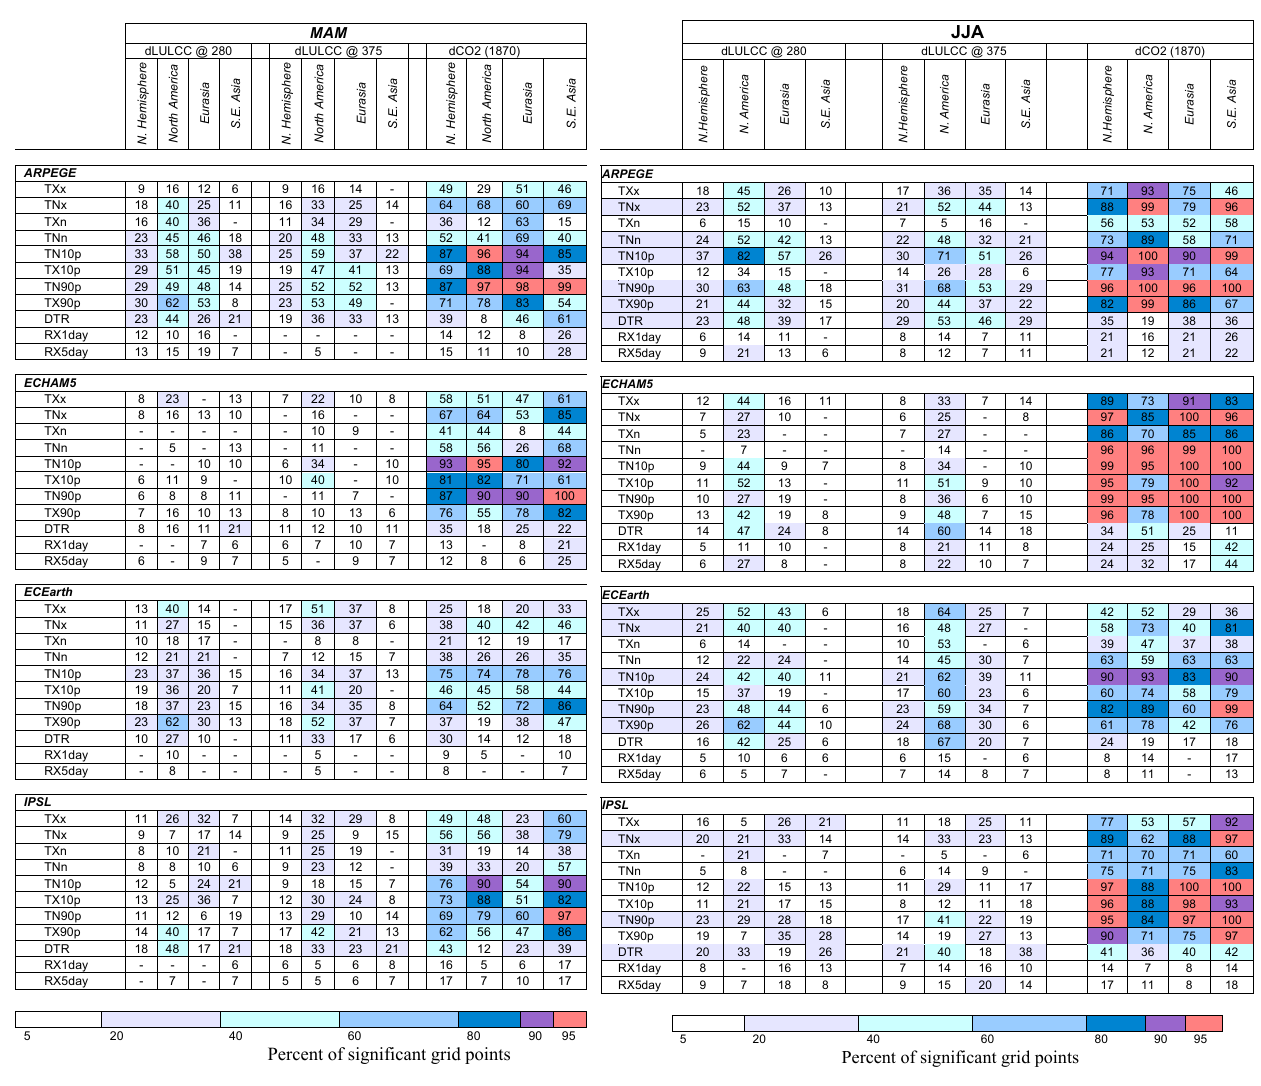
Table 5. Percent of significant grid points in four regions 745 for MAM and JJA for each model used in this paper. The first set of columns of data is for the impact of LULCC at 280ppmv, the second set of columns is for the impact of LULCC at 375ppmv. The final set of columns is for the impact of the increase in CO 2 from 280ppmv to 375ppmv. Dashes represent points where no grid points were